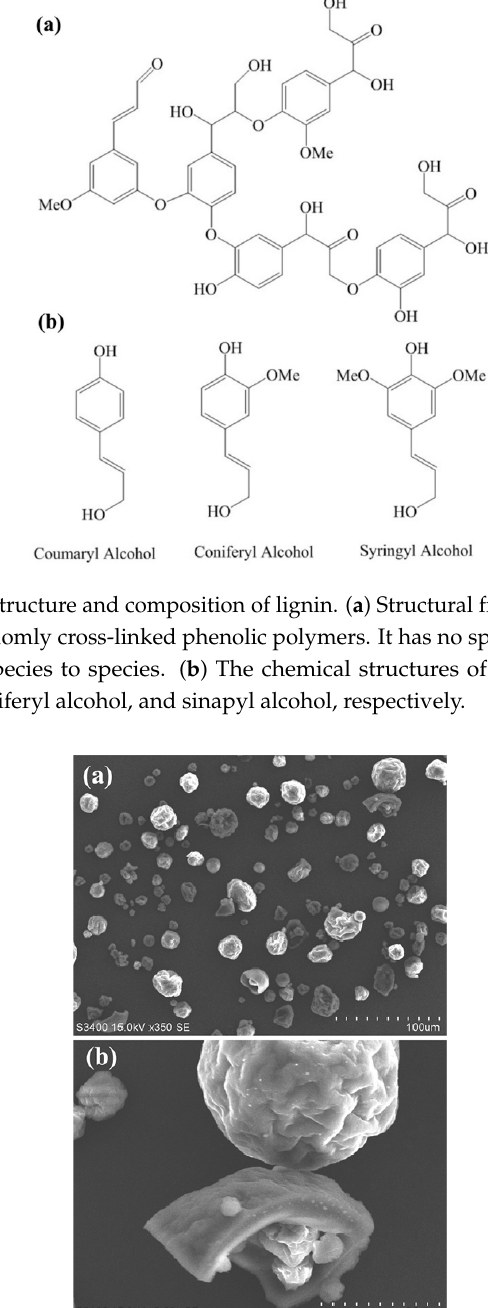
Figure 3. The SEM (scanning electron microscope) images of lignin particles obtained from an ethanol-water solution by evaporation of the solvent. ( a ) Most lignin particles are rough spheres with a diameter of tens to hundreds of micrometers. ( b ) A close view of larger lignin particles. Some of the lignin particles may be hollow spheres or pieces of broken spheres.